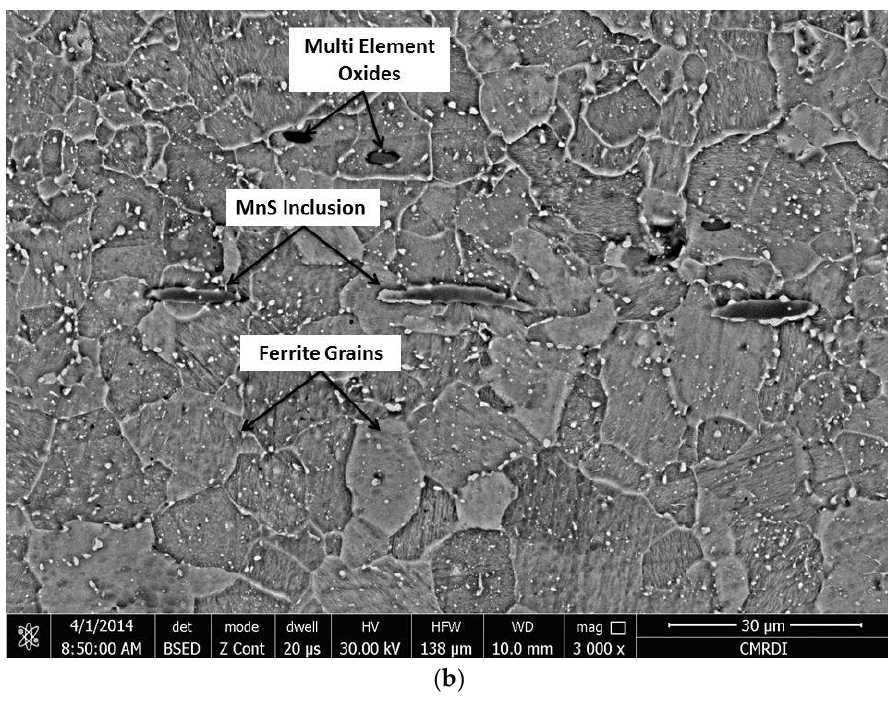
Figure 1. ( a ) Optical image of microstructure (magnification 200×) and ( b ) scanning electron microscopy (SEM) image of microstructure (magnification 3000×) of the as ‐ received (AR) sample.